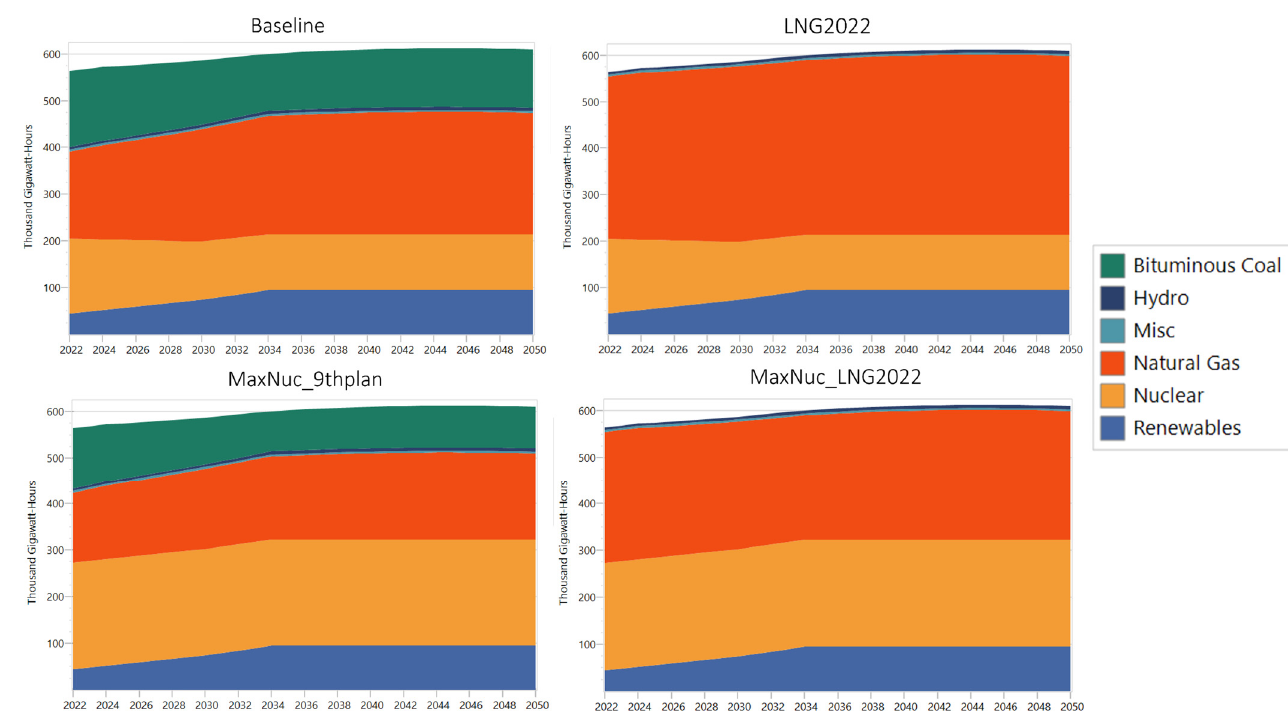
Figure 6. Gigawatt-hour (GWh) production by energy source in each scenario. In each of the three alternative scenarios, population exposure to PM2.5 is reduced compared to the baseline scenario, as shown in Figure 7. The “MaxNuc_LNG2022” sce- nario, in which 2022 nuclear capacity is maintained and its use maximized, and all re- maining coal electricity generation is replaced by LNG, has the largest PM2.5 exposure reduction impact, followed by the “LNG2022” scenario and then the “MaxNuc_9thplan” scenario.